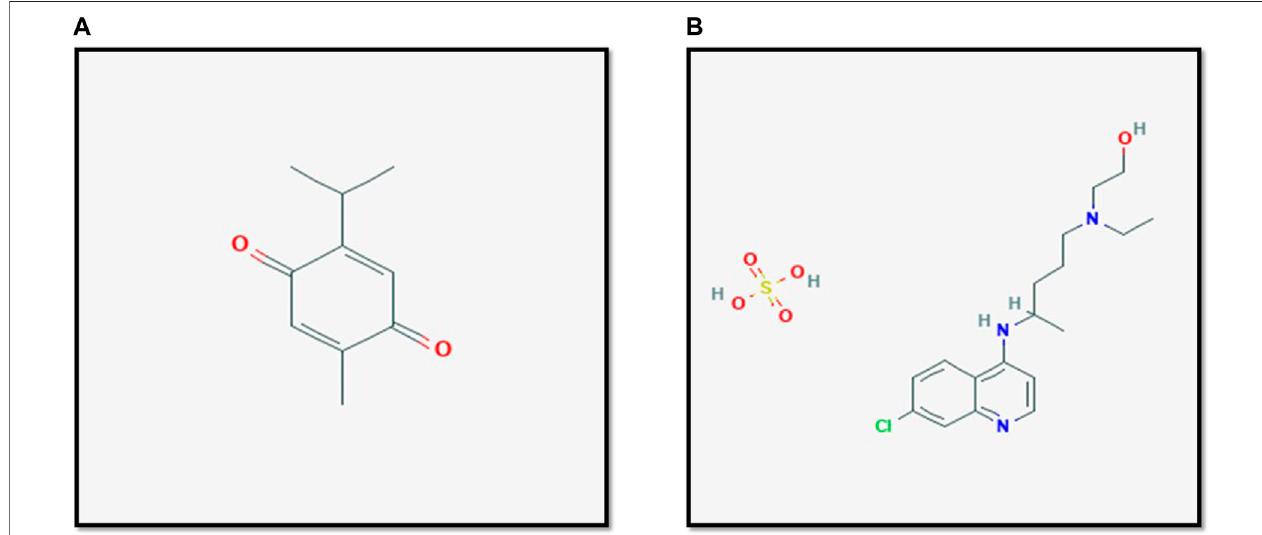
FIGURE1| ThestructureofThymoqunione (A) andHydroxychloroquine (B) .ThemolecularformulaofHydroxychloroquinesulfateisC 18 H 28 ClN 3 O 5 S,whereasitis C 10 H 12 O 2 for Thymoquinone. Thus, it is unlikely for both chemical structures to have similar effects. Figures are adapted from PubChem (National. Center for Biotechnology Information, 2021a; National. Center for Biotechnology Information, 2021b).